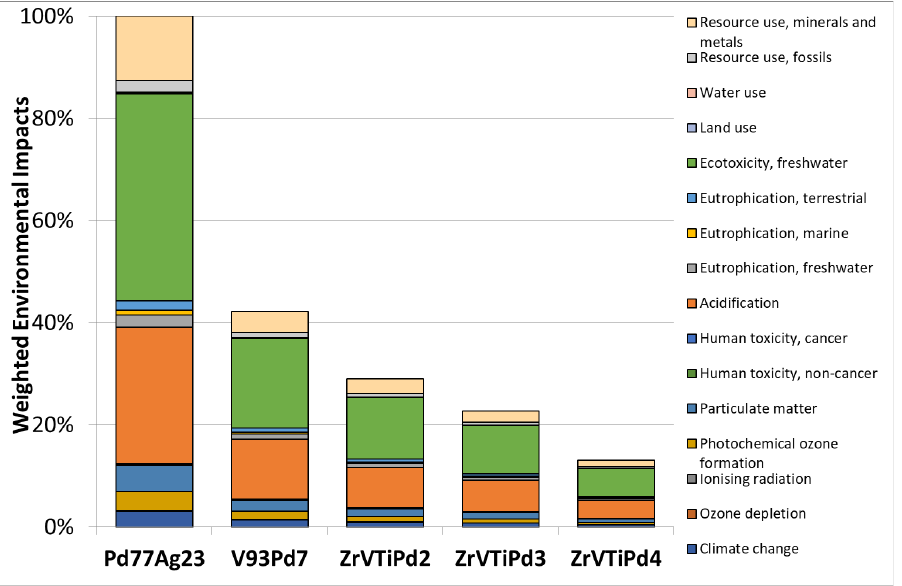
Figure 9. Comparison of weighted environmental impacts of different membrane compositions and Pd contents relative to Pd 77 Ag 23 , rescaled by the material permeance performance.